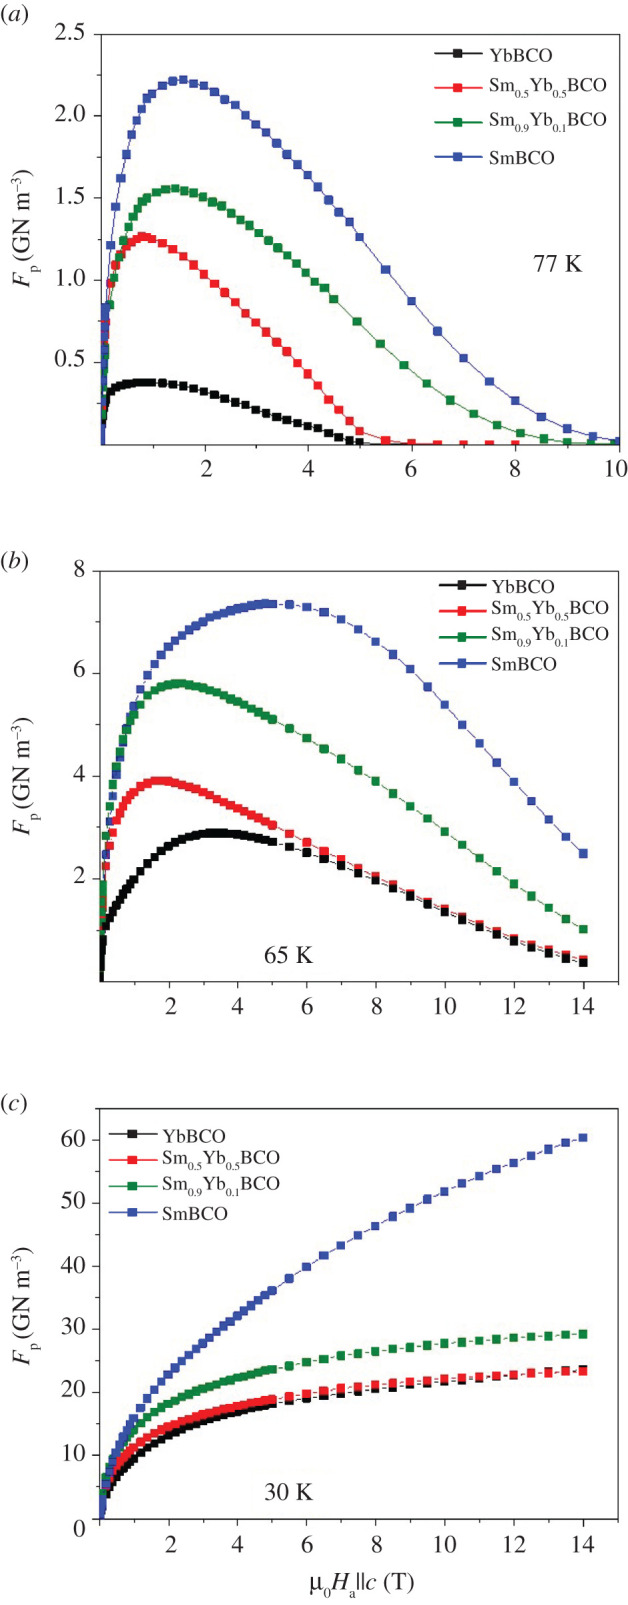
Fp dependence on magnetic field of Yb1−xSmxBa2Cu3O7−δ films at (a) 77, (b) 65 and (c) 30 K.